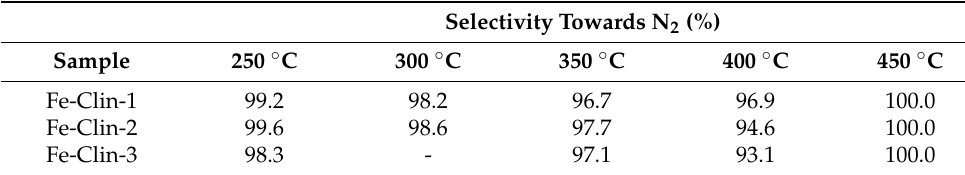
Table 3. N 2 selectivity of Fe-clinoptilolite catalysts.